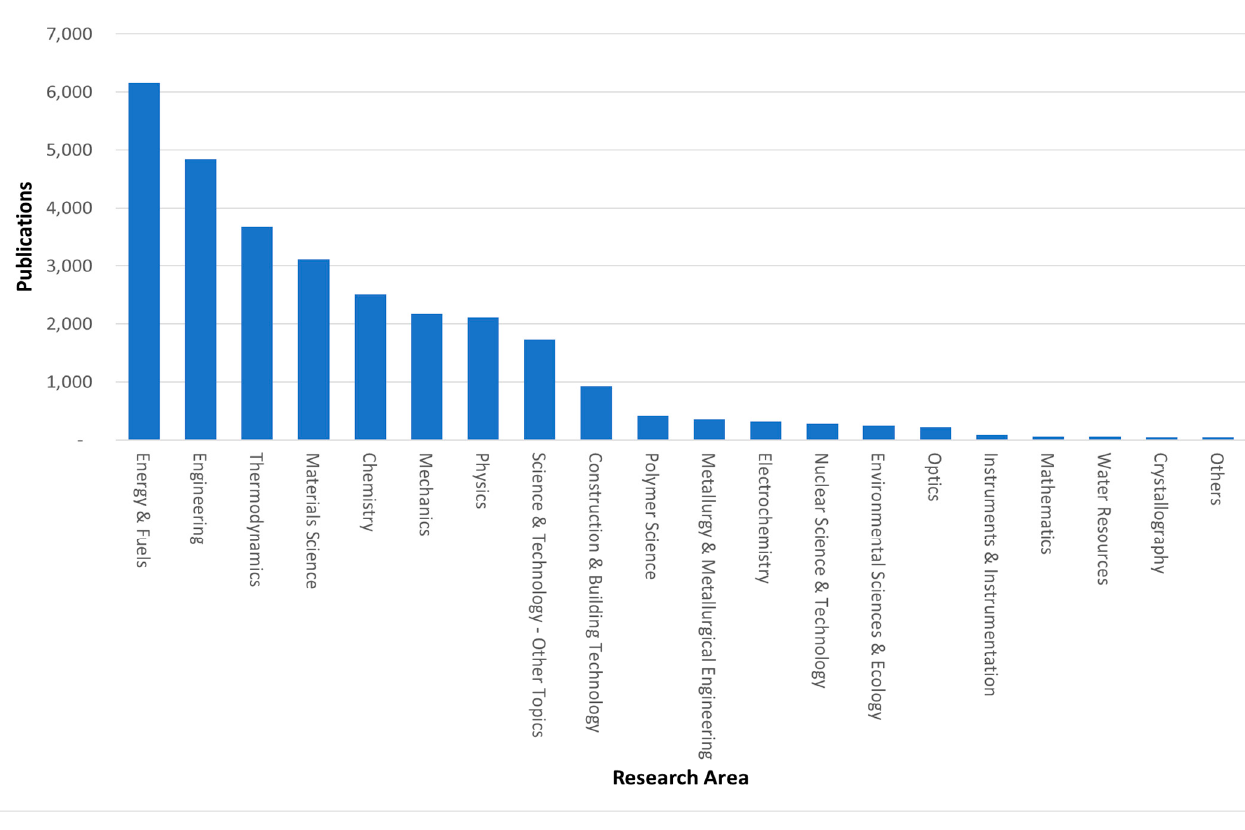
Figure 11. Indexed research areas preferred by the research community to publish their advances in materials for TES field considering the last 5 years publications. Table 2. Scientific dissemination of TESM over the last two decades, the top 20 journals (with the most publications) on the scope of TES and TESM, with the number of papers, citations and performance ratio (PR).